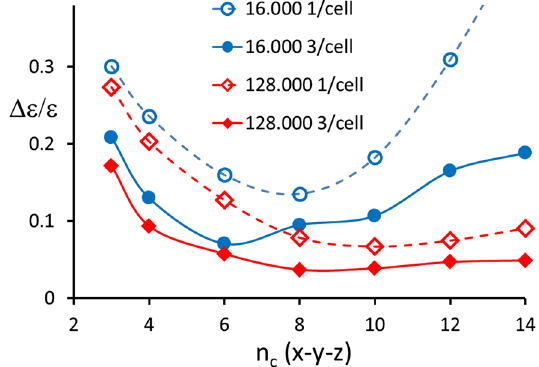
FIG. 12. Drift tube Linac cell option for FODO: Relative growth of ϵ 6 d for N ¼ 16 . 000 = 128 . 000 , as function of number of grid cells in x; y; z in same lattice structure as Fig. 11.